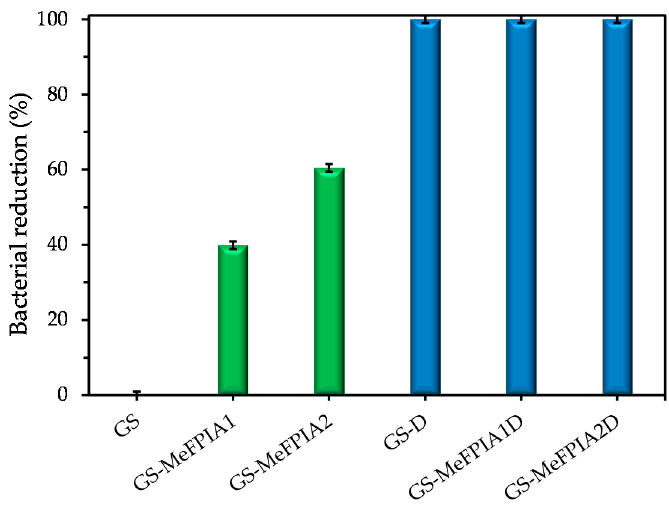
Figure 7. Bacterial reduction percentage against S. aureus bacteria of the different